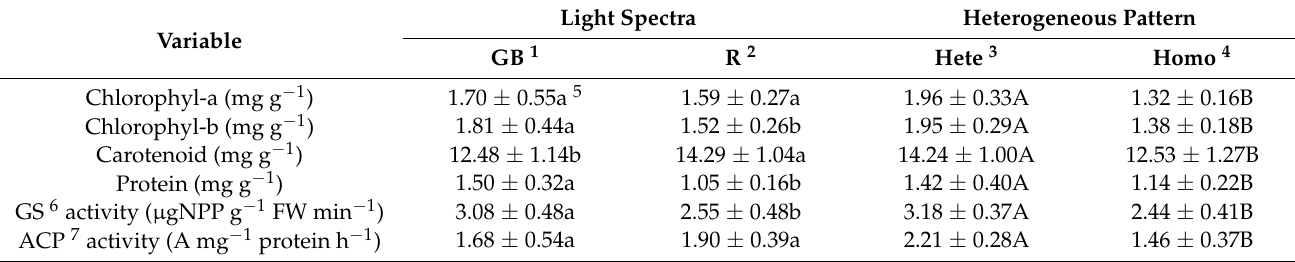
Table 2. Foliar variables in Pinus pumila (Pall.) Regel seedlings subjected to contrasting light spectra and heterogeneous patterns.